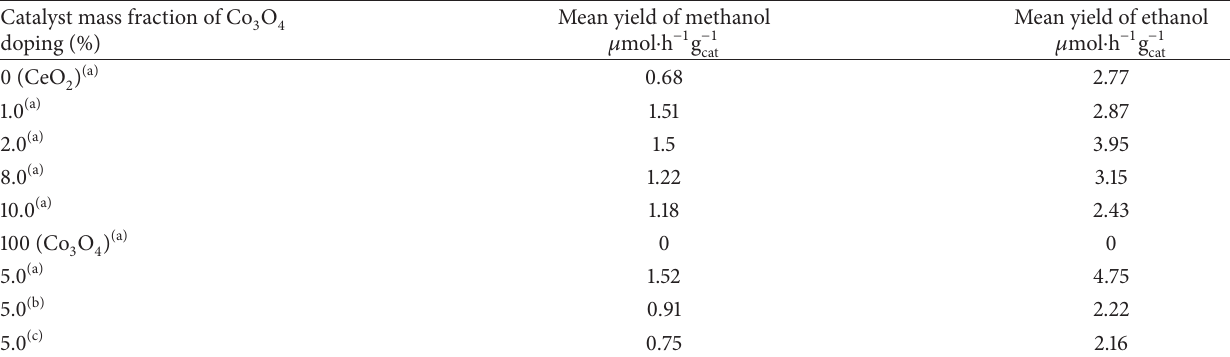
O /CeO catalysts under visible light irradiation ( 𝜆 > 400 nm). 3 4 2